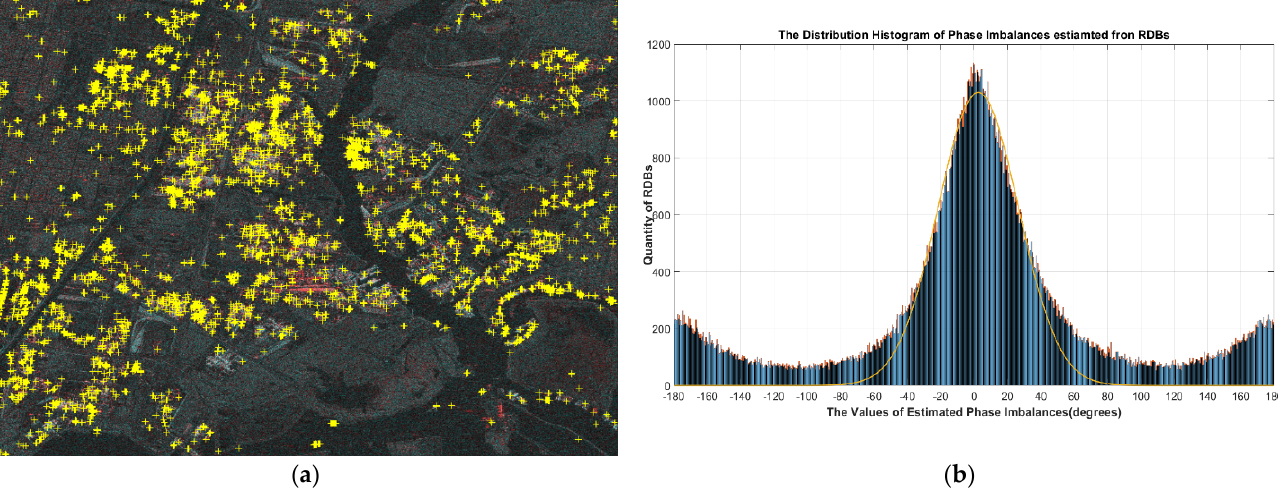
Figure 4. The phase imbalance estimation results of Sentinel-1 dual-pol SAR data: ( a ) The extracted RDBs are displayed in a local area of the Houston urban area (Scene: S1A_S3_SLC__1SDH_20160922T001818_20160922T001841_013158_014E8E_7926 ). The color assignment is red for the HH channel, green for the HV channel, and blue for the HV channel divided by the HH channel; ( b ): The distribution histogram of the estimated phase imbalances.